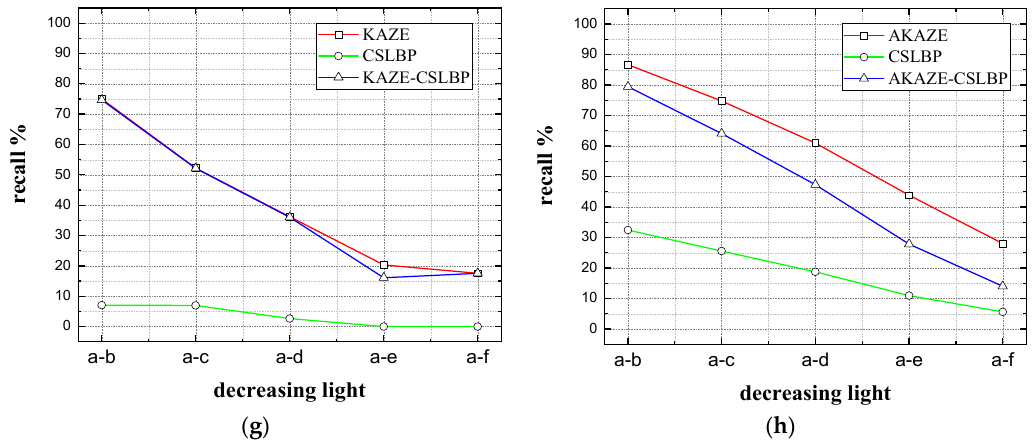
Figure 9. Matching results of the recall of Leuven sequence for the eight original, the CSLBP, and the combined descriptors. The X label represents the matched images of Leuven sequence, and the Y label denotes the recall for each descriptor. ( a ) SIFT features; ( b ) SURF features; ( c ) DAISY features; ( d ) BRISK features; ( e ) ORB features; ( f ) FREAK features; ( g ) KAZE features; ( h ) AKAZE features.